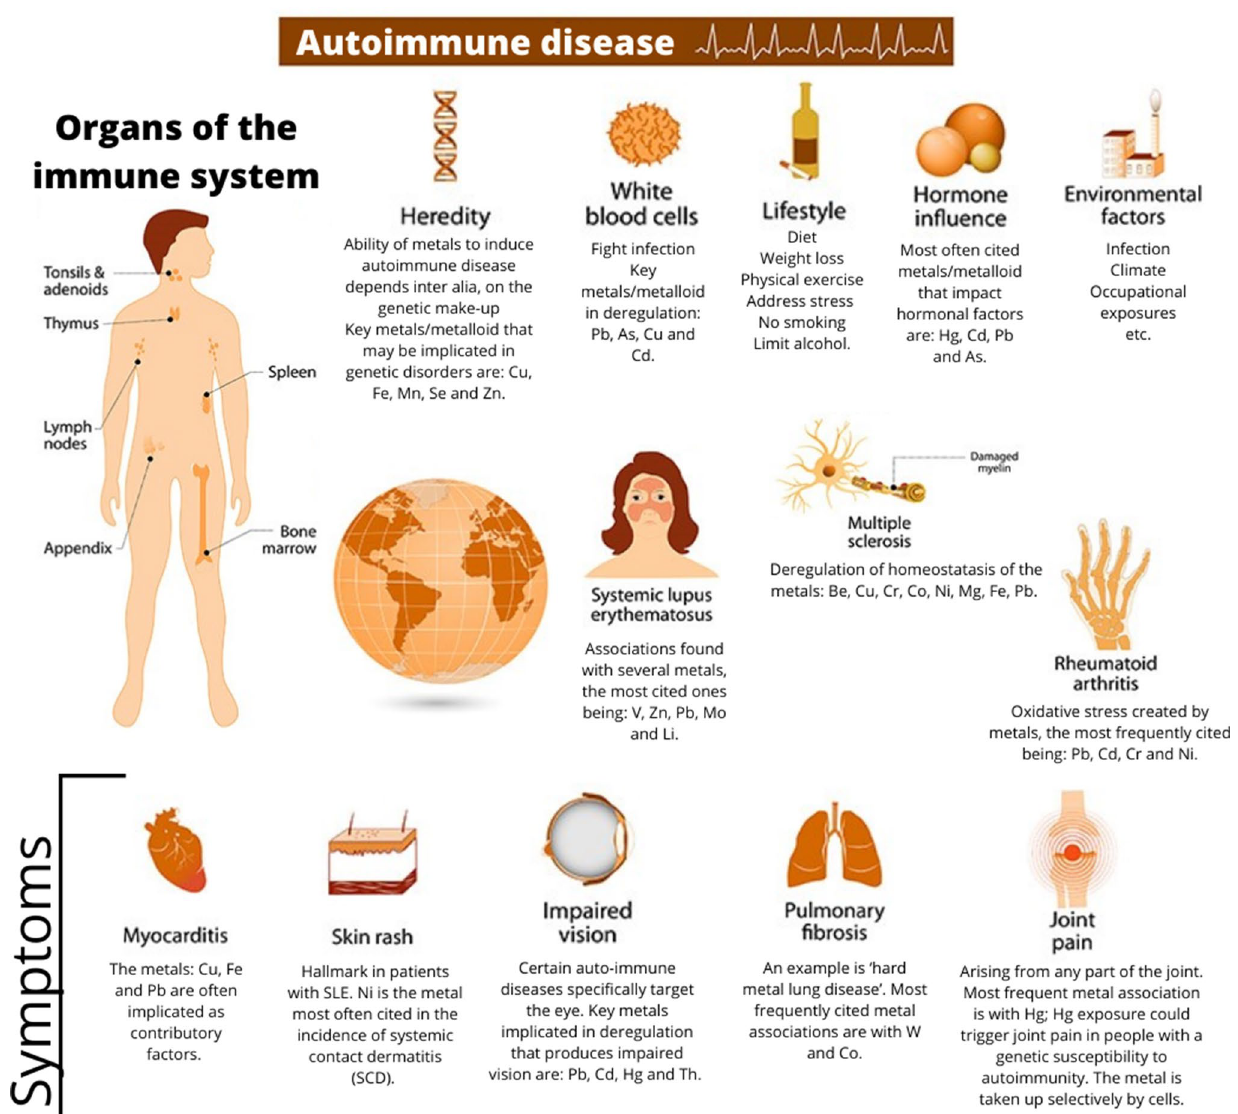
elements/metals involved in deregulation are given for each cor- responding autoimmune disease portrayed. Image by the